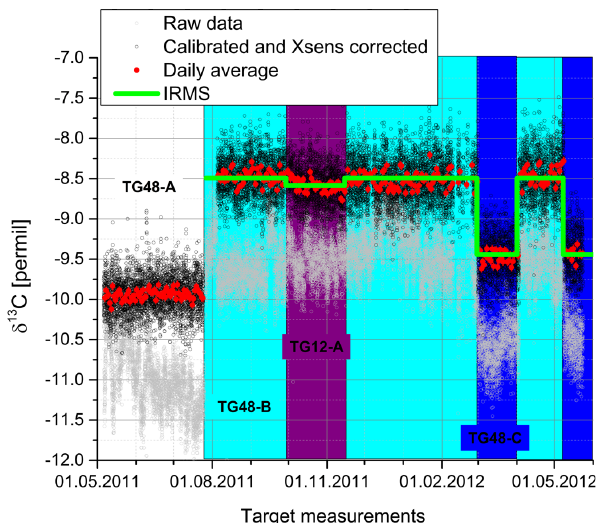
Fig. 6. Time series of the 10min averaged target measurements passed through the system every 30min. The Picarro raw data is shown in grey. The calibrated data is in black and daily averages of the δ 13 C TG are shown in red. The externally calibrated δ 13 C val- ues (using the EC IRMS system) are shown in green. Periods in which different sets of target gases are used are indicated by the background coloring (cf. Table